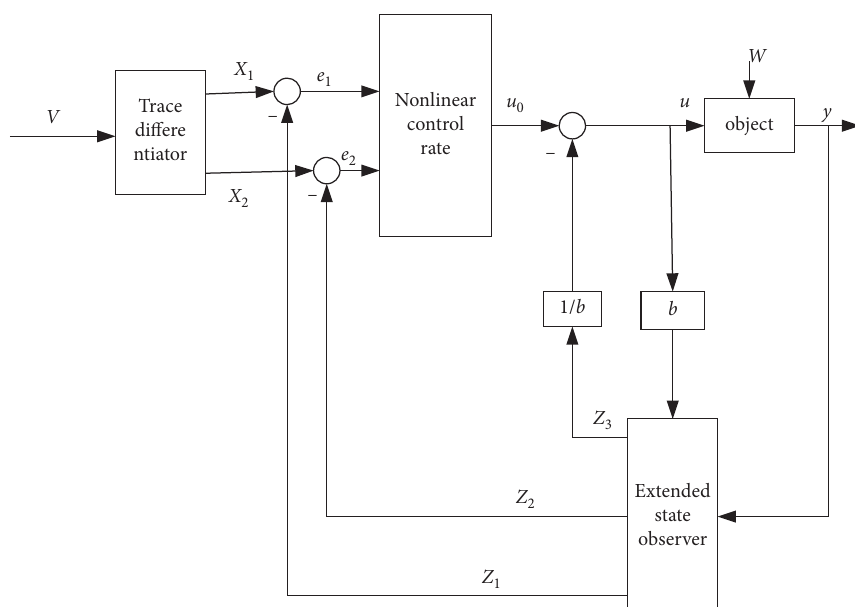
Figure 1: Structure of automatic disturbance rejection control